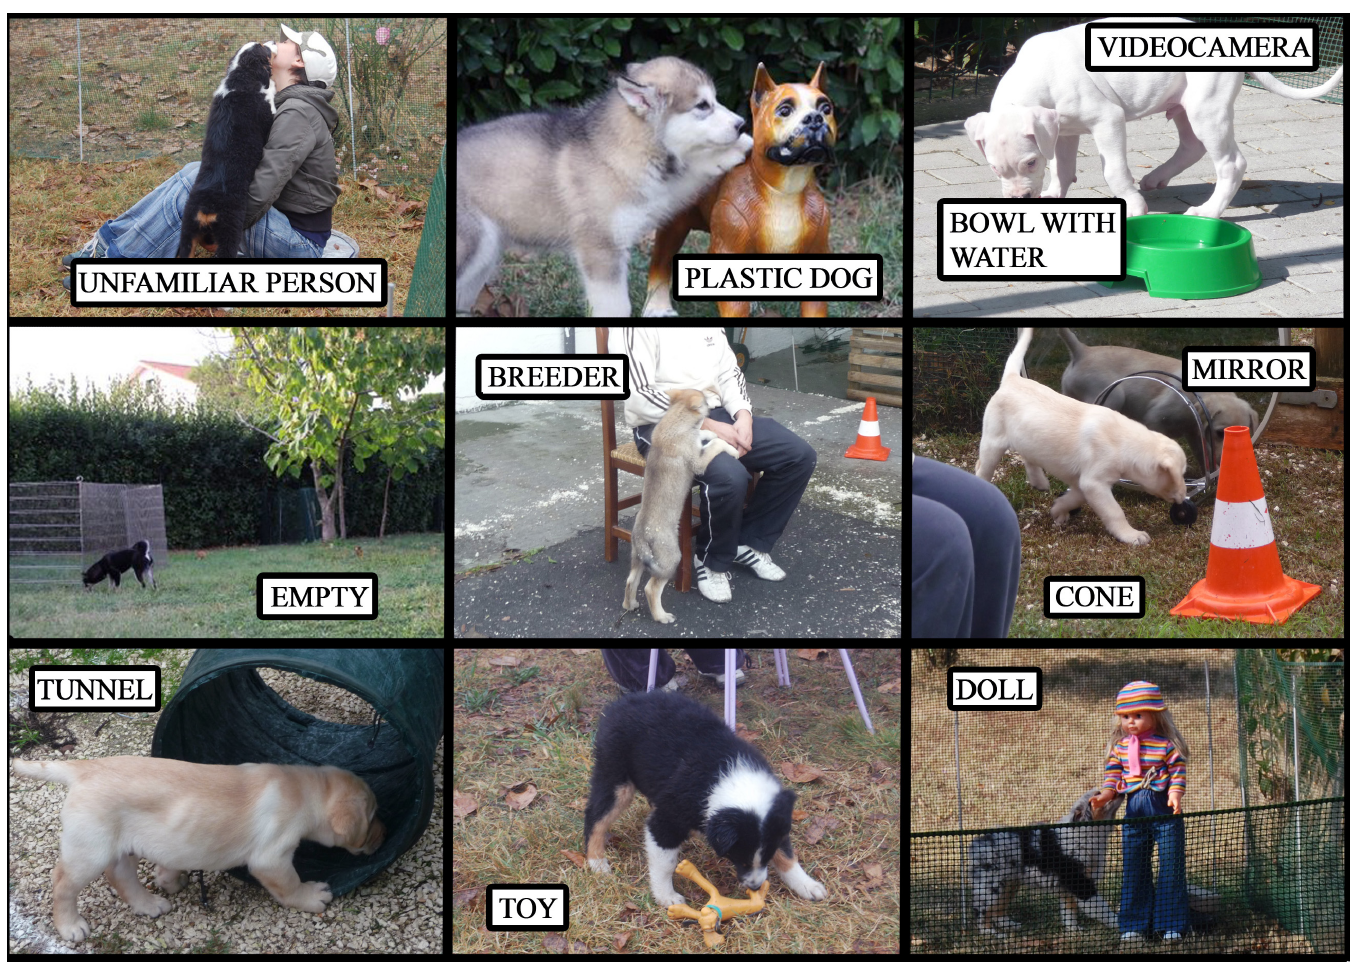
Fig 1. Stimuli and setup in the modified open-field